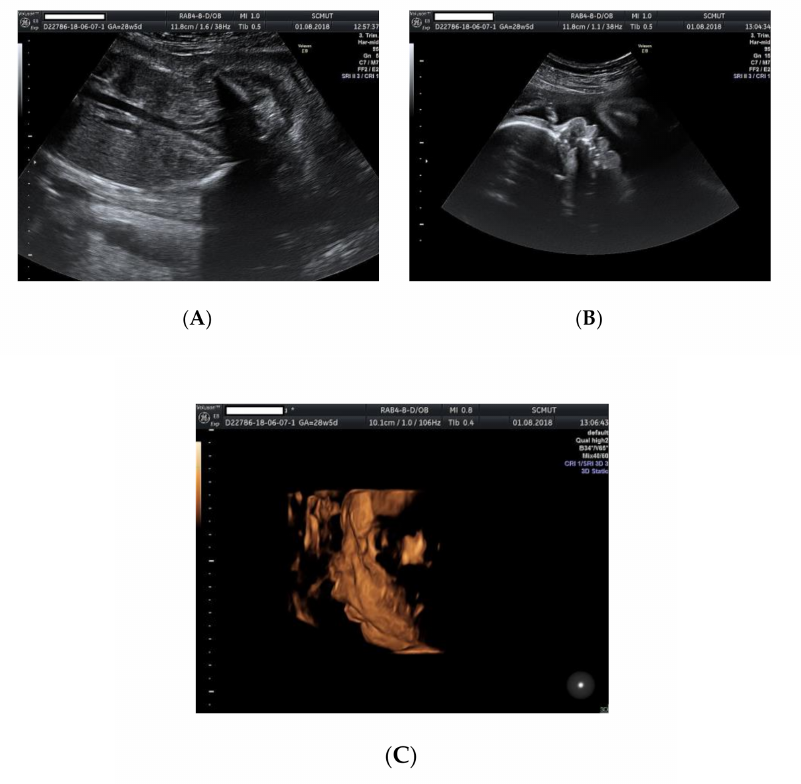
Figure 3. Ultrasound examination of the fetus: ( A ) small kidneys located in the iliac fossa;